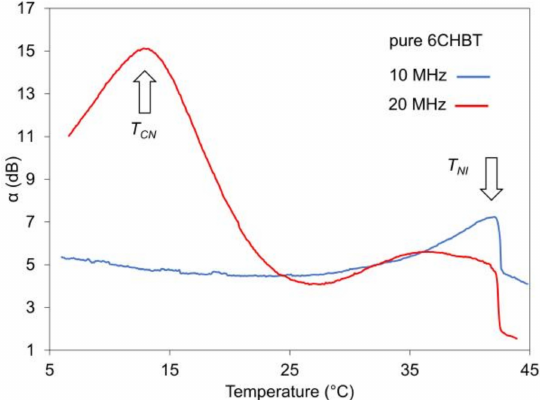
Figure 6. Temperature dependence of SAW attenuation of pure 6CHBT for di ff erent frequencies (10 and 20